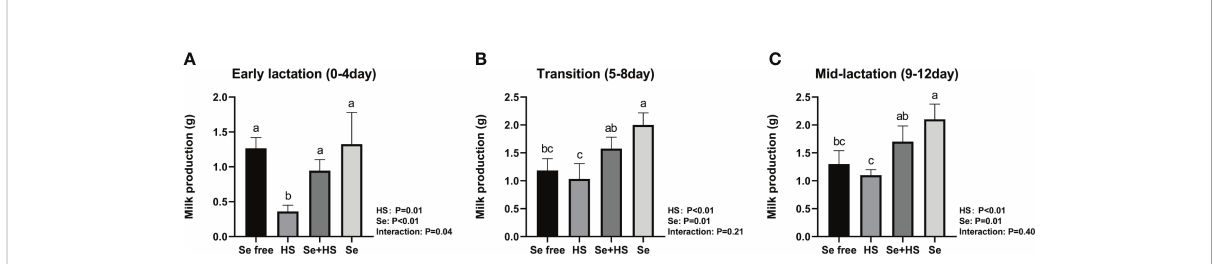
FIGURE 6 Effects of HMSeBA on milk production of mice under HS (n = 12). (A) Early lactation (0-4 day). (B) Transition (5-8 day). (C) Mid-lactation (9-12 day). a-d Different lowercase letters indicate extremely signi fi cant differences between two groups ( P < 0.01), while the same lowercase letters indicate no signi fi cant difference between two groups ( P > 0.05).